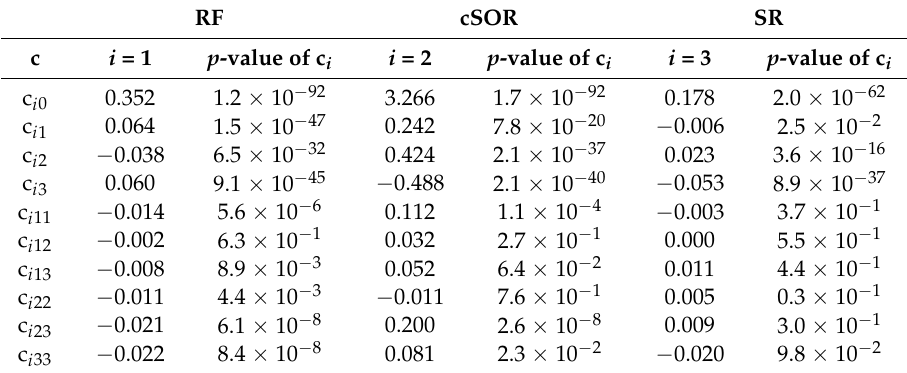
Table 4. R egression c oefficient vector c and its p -values for each response surface model. Table 4. Regression coefficient vector c and its p -values for each response surface model.